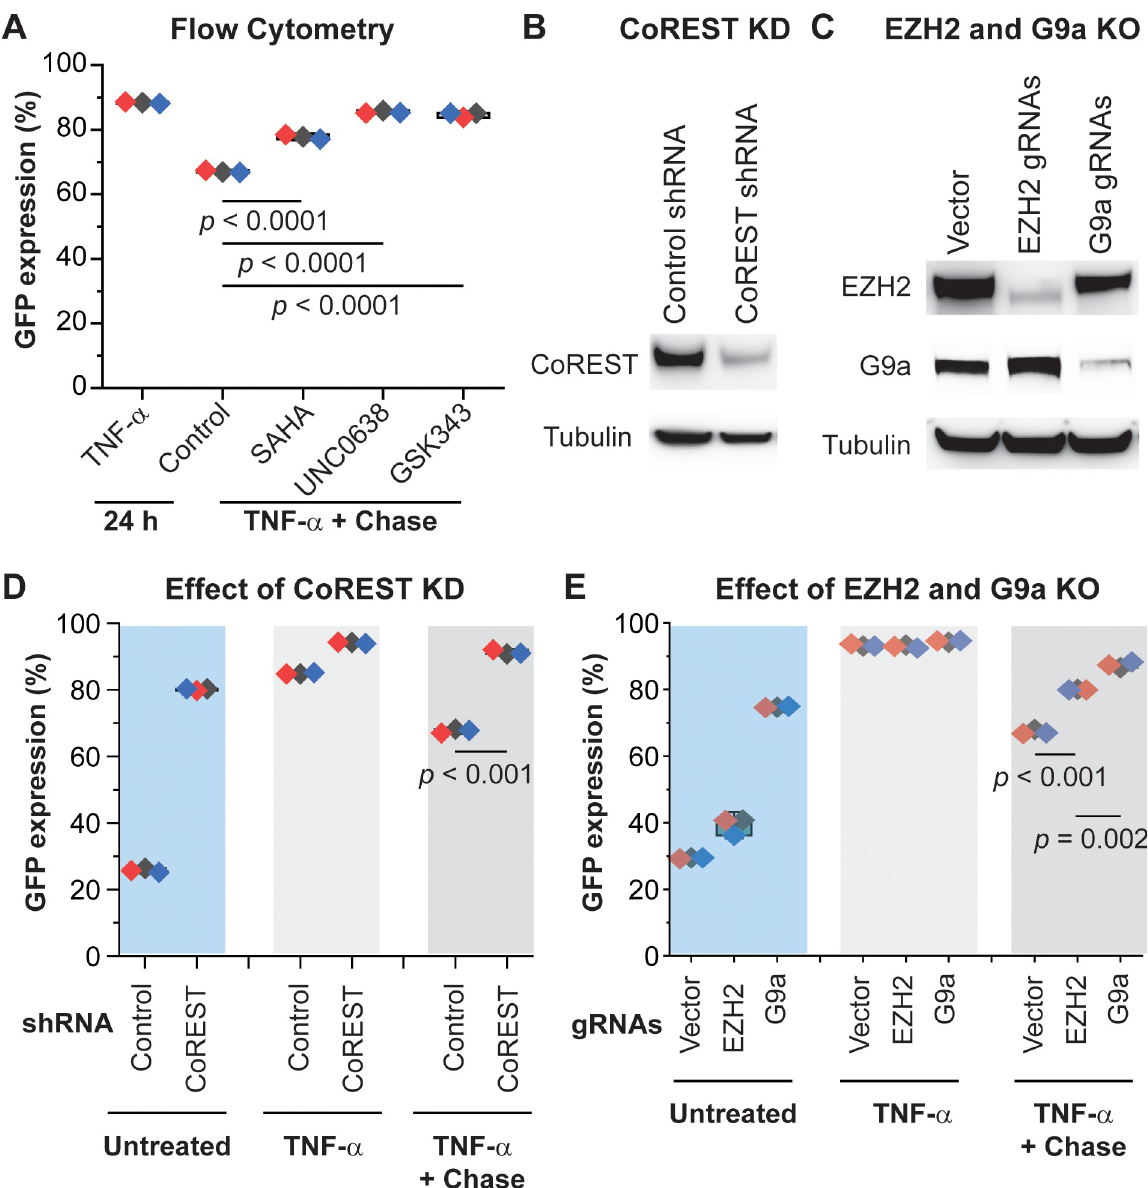
Fig 9. The CoREST repressor complex plays a pivotal role in silencing active HIV in microglial cells. A, Inhibition of HDAC1, G9a, and EZH2 blocked silencing of activated HIV in HC69 cells. HC69 cells were stimulated with high dose (400 pg/ml) TNF- α for 24 hr. After washing with PBS, the cells were cultured in the presence of DMSO (placebo, Control), HDAC inhibitor SAHA (1 μ M), G9a inhibitor UNC0638 (1.25 μ M), or EZH2 inhibitor GSK343 (1.25 μ M), for 48 hr. The levels of GFP expression for each treatment were measured by flow cytometry and calculated from three independent experiments, with p values between the control and treatment with each inhibitor indicated. B, Verification of CoREST KD by Western blot detection of CoREST protein expression in HC69 cell lines stably expressing control shRNA or CoREST-specific shRNA. C, Verification of EZH2 and G9a KO by Western blot detection of G9a and EZH2 protein expression in HC69 cells stably expressing CRISPR/Cas9 and G9a or EZH2 specific gRNA, which were compared to the control HC69 cells stably expressing CRISPR/ Cas9 without gRNA. β -tubulin was used as a loading control for all Western blot analysis. D, CoREST KD prevents HIV silencing. The HC69-control shRNA and HC69-CoREST-shRNA cells were untreated, induced with high dose (400 pg/ml) TNF- α for 24 hr, or used in a chase experiment by continuous culturing the cells for 48 hr after TNF- α stimulation for 24 hr and washes with PBS. GFP expression levels of all cells were measured by flow cytometry and the mean values were calculated from three independent experiments. Significant differences were observed between the HC69-control shRNA and HC69-CoREST shRNA cell lines. E, G9a and EZH2 KO prevents HIV silencing. Evaluation of the HC69 cell lines expressing G9a or EZH2 specific gRNA or empty vector by flow cytometry following the same protocol as in panel D. There was a significant difference between HC69-vector and HC69 EZH2 or G9a KO cell lines at 48 hr after TNF- α withdrawal, with p < 0.01.